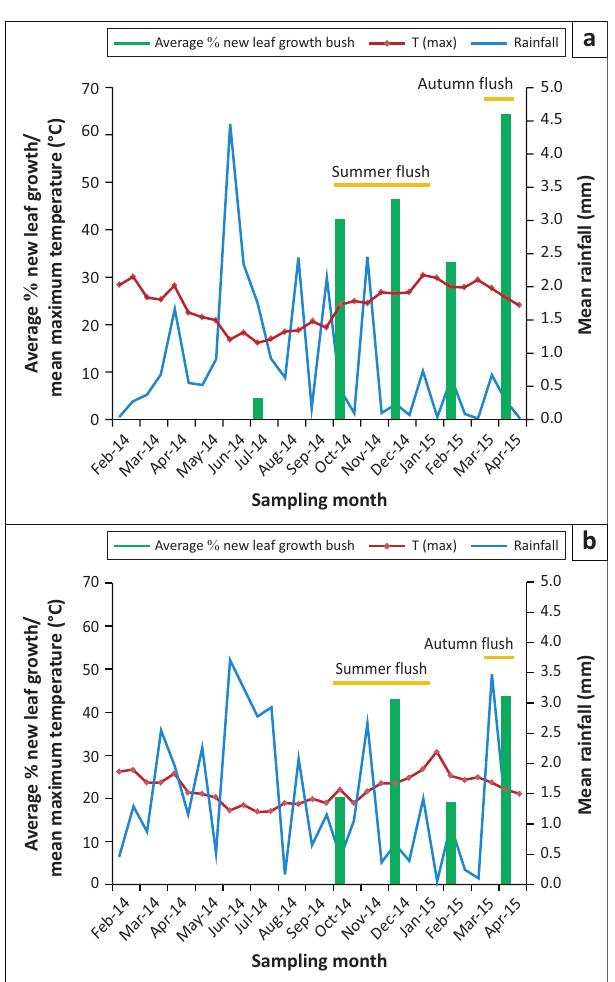
FIGURE 4: Average percentage new leaf growth (green bars on the primary y -axis) for (a) Cyclopia maculata and (b) Cyclopia genistoides with mean maximum temperature (°C) (diamond marked line as second entry on the primary y -axis) and mean rainfall (mm) for the study areas (on the secondary y -axis). Mean maximum temperature ( T ) and rainfall are given on a bi- max monthly basis. Phenological observations were made every two months from late July 2014 to April 2015 on sites in the Overberg, South Africa. TABLE 2: Mean diversity and richness indices (with respective standard errors, ± SE) of the insect assemblage associated with Cyclopia species as sampled by d-vac from April 2014 to January 2015 in the Overberg region, South Africa. Index C. maculata